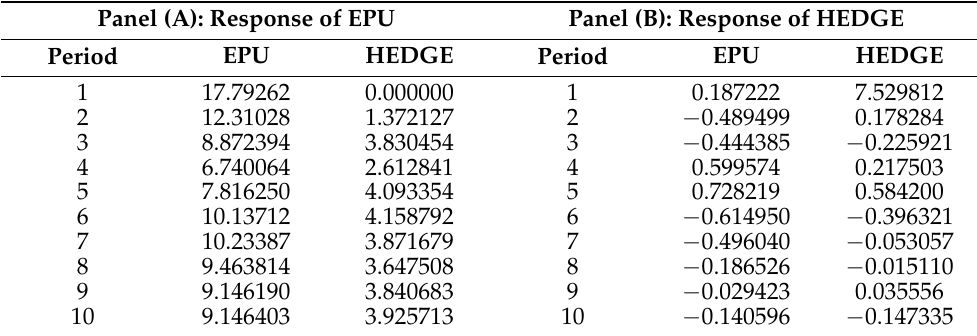
Table 12. Impulse response function results.